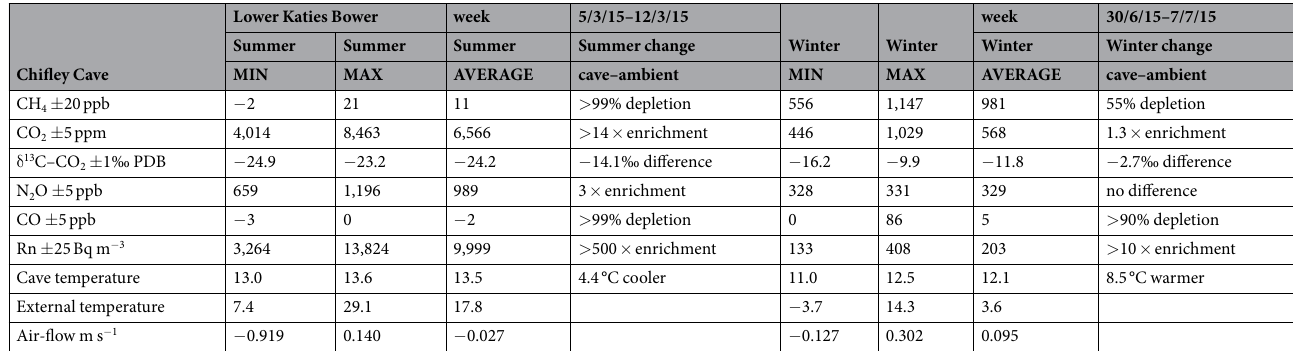
Table 1. Summary of trace gases in Chifley Cave, measured in Lower Katies Bower during two typical weeks in summer and winter. A week is approximately the duration of a single synoptic cycle where the external temperature range and pressure remain stable causing a pattern of cave ventilation air-flow typical of the season. The change in the cave environment is relative to the synchronous trace gas measurement of the external ambient atmosphere using 8-minute averages taken hourly and averaged over approximately a week. Weekly averaging removes the diurnal cycle (MIN & MAX) from the reported change between cave and ambient atmospheres. There is a marked seasonal difference in the magnitude of depletion or enrichment for each trace gas reflecting the dominant air-flow direction with different sources of trace gases (Summer – soil & external ambient air, Winter – external ambient air). Comparison of weekly average cave temperature to weekly average external temperature differs in sign and magnitude seasonally. The difference in temperature between cave and ambient causes the seasonal reversal of dominant air-flow with consequent winter seasonal bias in average air-flow velocity and air-mass ventilated through the cave. Doubling the temperature difference has caused a trebling of average air-flow